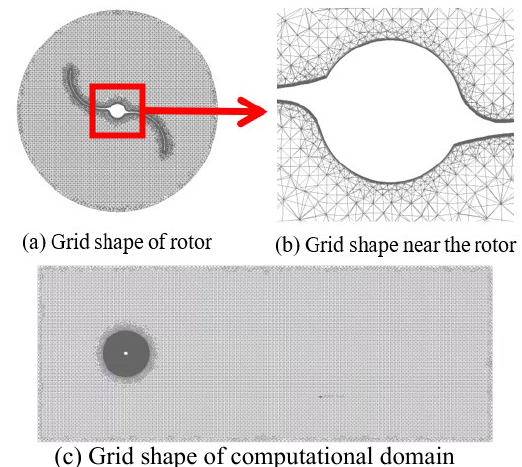
Figure 3. Local grid.